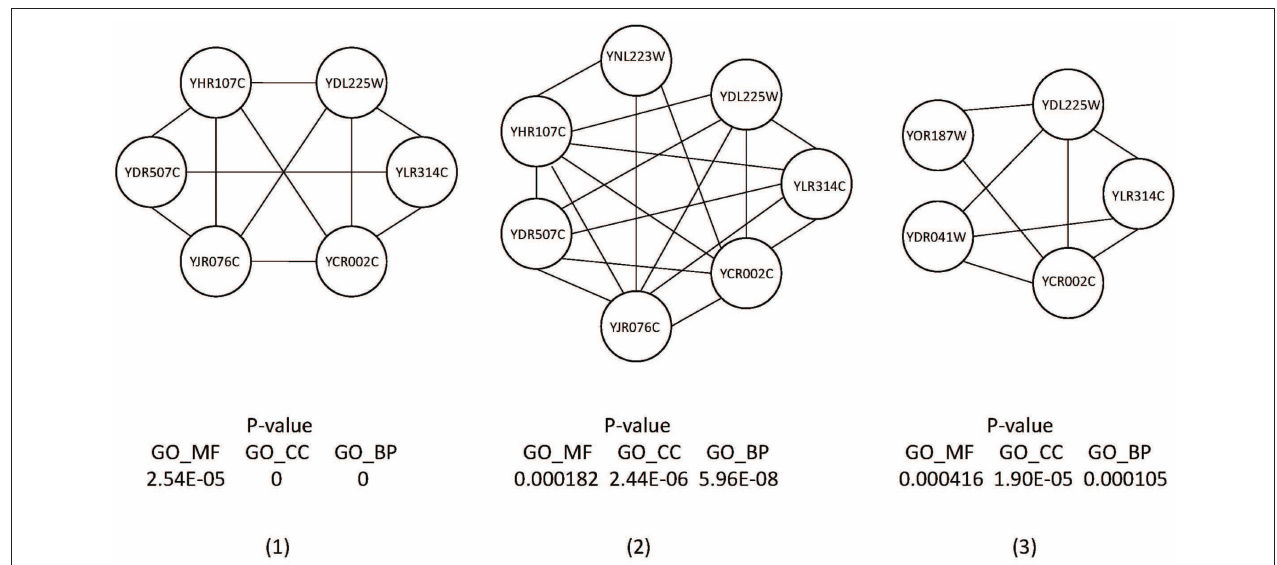
FIGURE 13 | The false positive protein complexes which have low P -value and high local